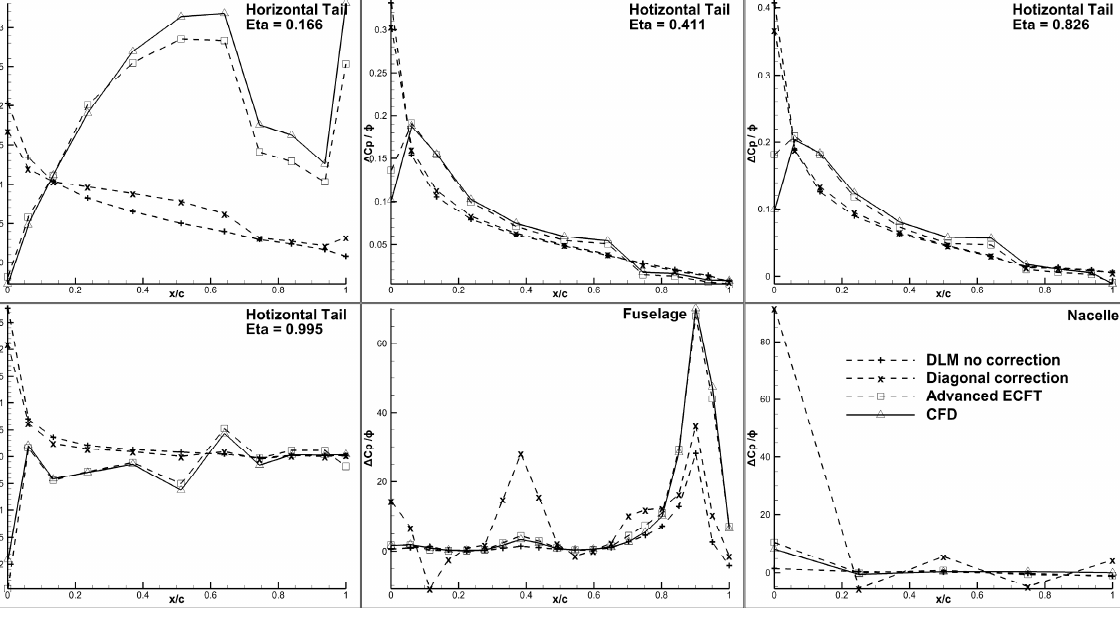
Figure 11. Elastic Δ Cp for a unit ϕ in the horizontal tail, fuselage, and nacelle component. Figure 11. Elastic ∆ Cp for a unit ϕ in the horizontal tail, fuselage, and nacelle